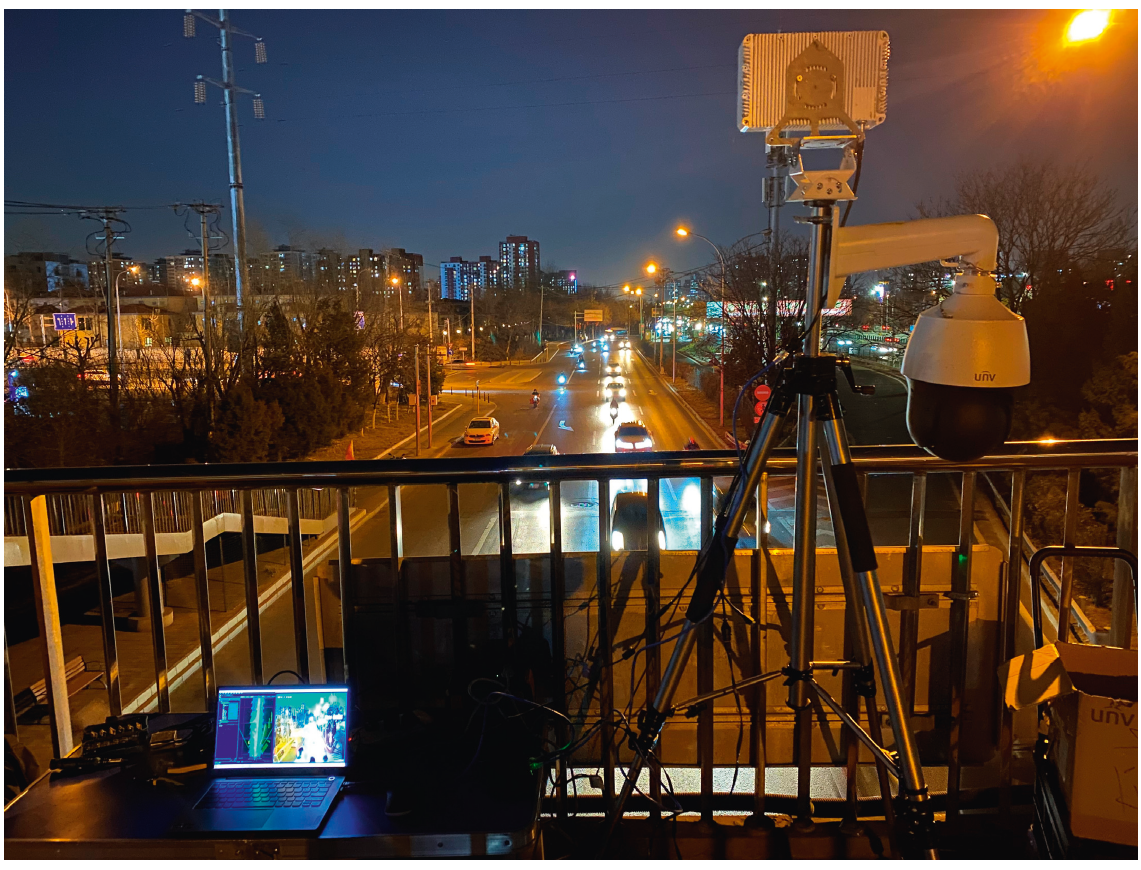
Figure 14: Long road scenario in